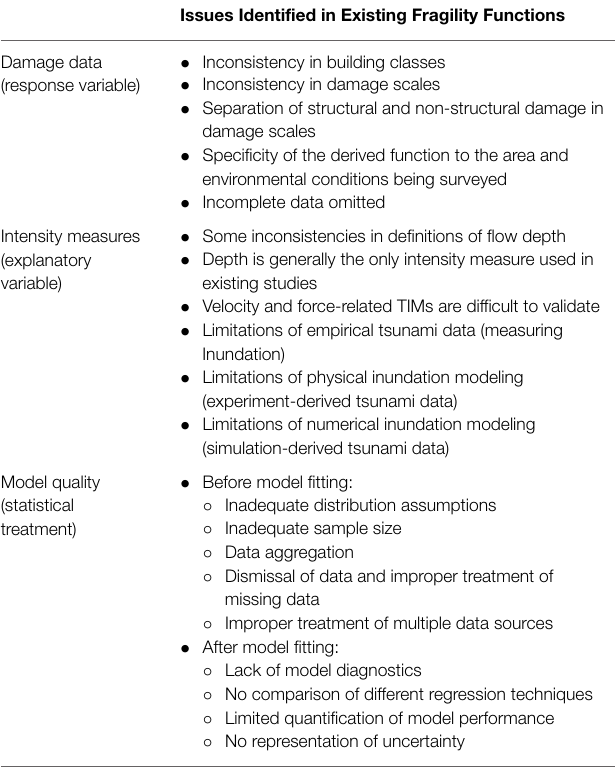
TABLE 12 | Issues with current fragility functions, organized by model component. Issues Identified in Existing Fragility Functions Damage data (response